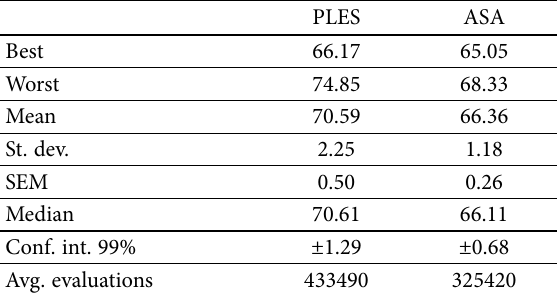
Table 16. Performance of the PLES and the ASA